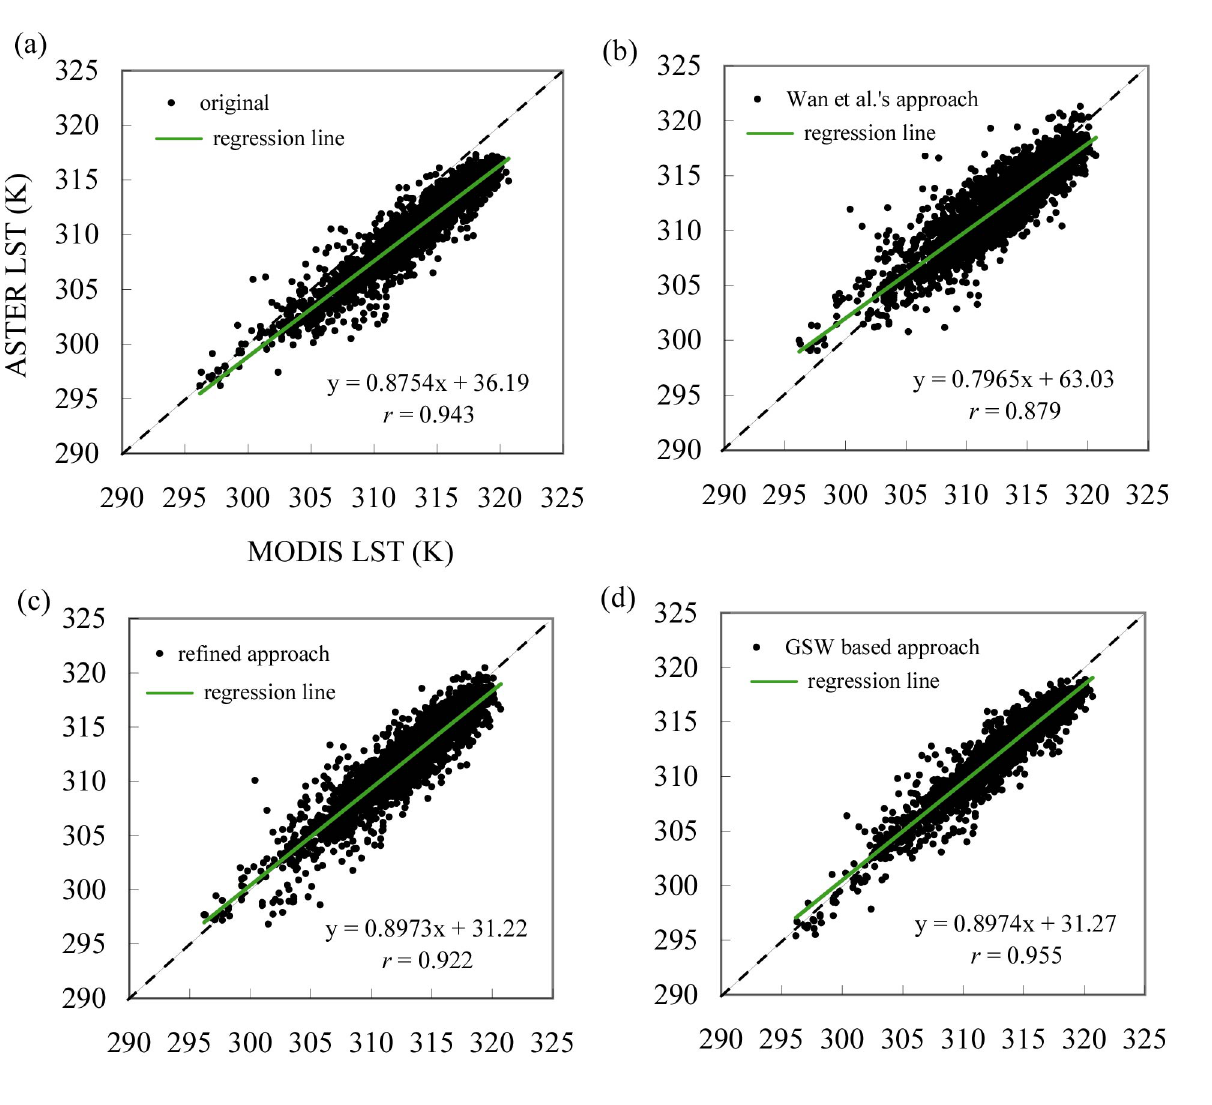
Figure 1. Scattergram of MODIS LST versus scaled ASTER LST without terrain correction for the case (a) The original MODIS MOD11_L2 LST, (b) The MODIS LST corrected using the Wan et al’s approach, (c) The MODIS LST corrected using the refined approach, and (d) The MODIS LST corrected using the GSW algorithm based